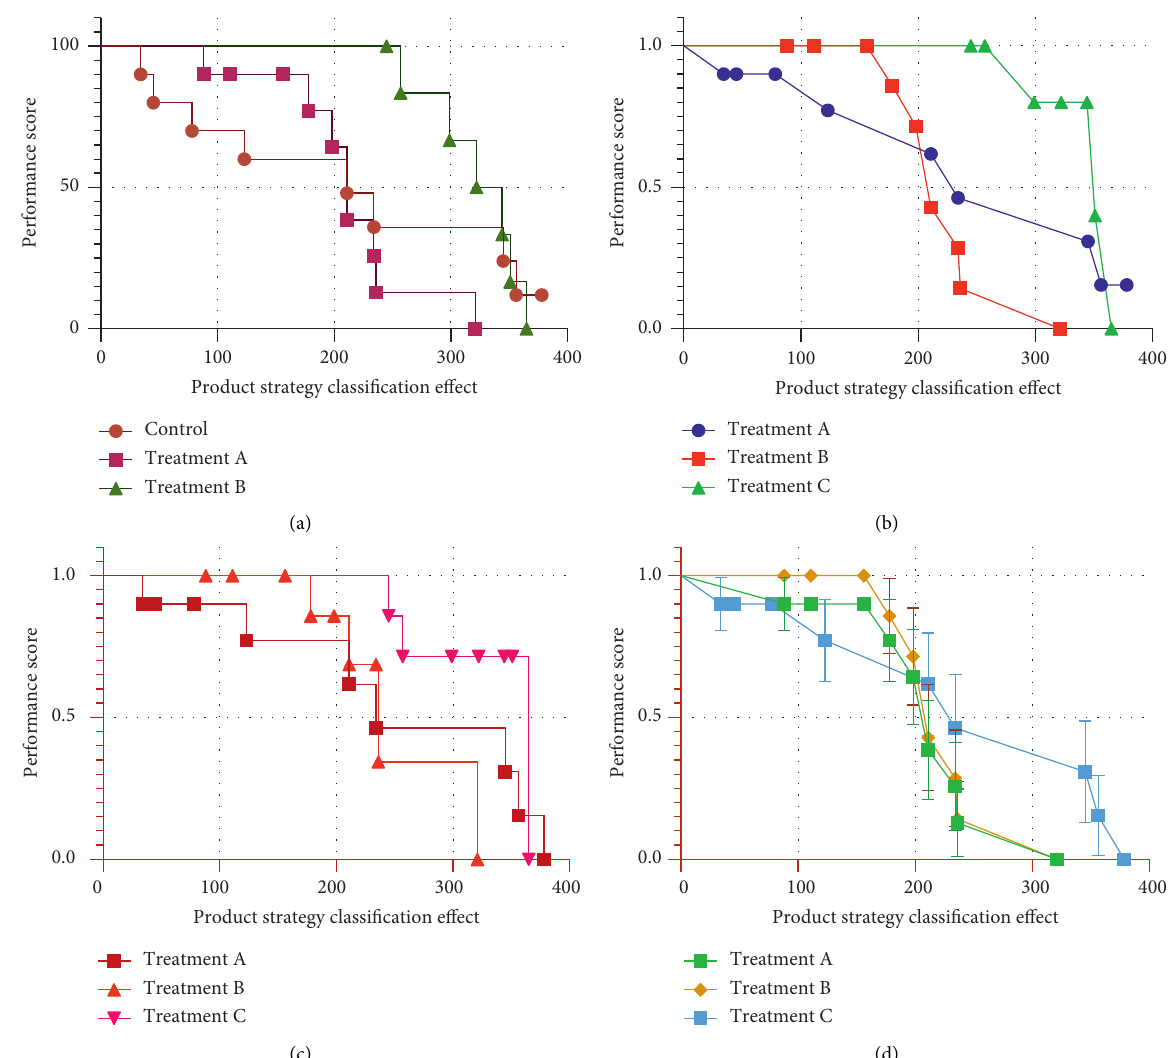
Figure 4: Product strategy classification effect results. (a) Original: three groups. (b) Treatment A: three groups. (c) Treatment B: three groups. (d) Treatment C: three groups.